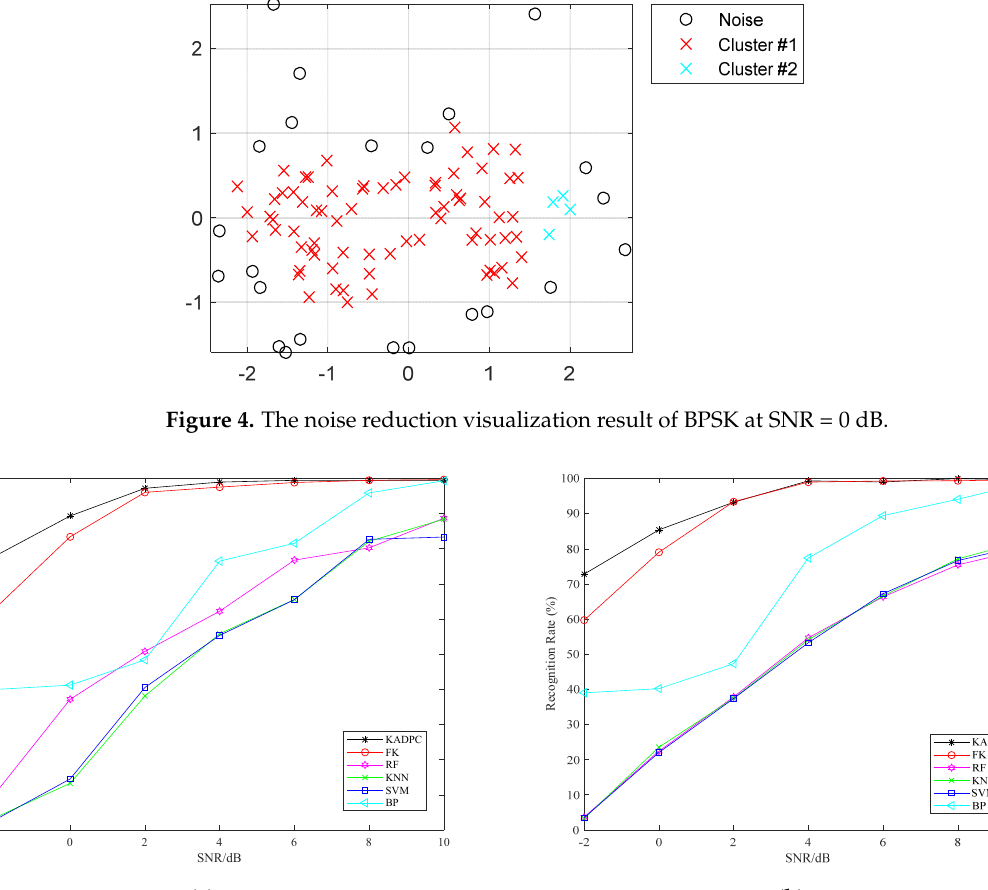
Figure 4. The noise reduction visualization result of BPSK at SNR = 0 dB.